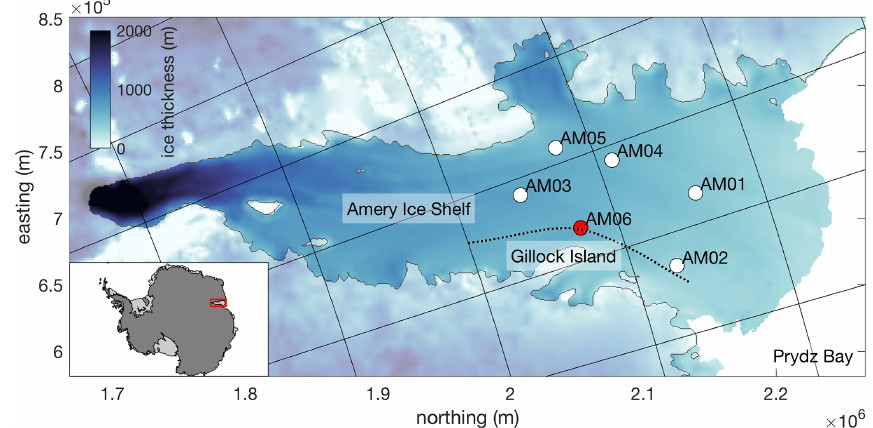
Figure 1. Ice thickness map of the Amery Ice Shelf in polar stereographic projection with borehole sites AM01–6 labelled. Site AM06 (magenta) is the focus of this paper. The floating ice shelf is denoted by the bold colours, and the dashed line is the local ice flowline, calculated using the MATLAB flowline function (Greene, 2022) and MEaSUREs ice velocities (Rignot et al., 2017). The map was produced with Antarctic Mapping Tools (Greene et al., 2017) using the Bedmap2 product (Fretwell et al.,